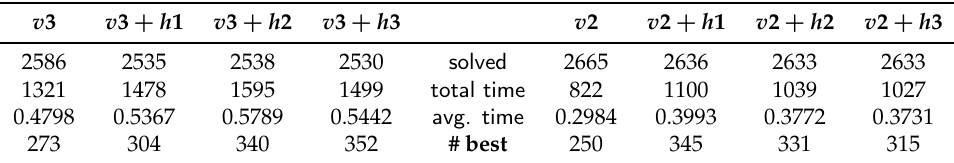
Table 2. Analysis on the impact of heuristics h 1, h 2, and h 3, on the best sequential ( v 3) and the best parallel ( v 2) version.